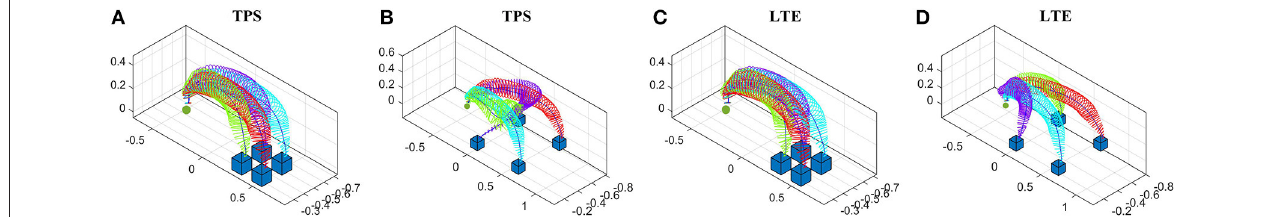
FIGURE 10 | Generalization of the learned pick-and-place skill over four novel final states. (A,B) Using TPS through Algorithm 3 , and (C,D) using LTE through Algorithm 4 . New locations of the box in (A,C) are close to the original location of the box, while the new box locations are farther in (B,D) .